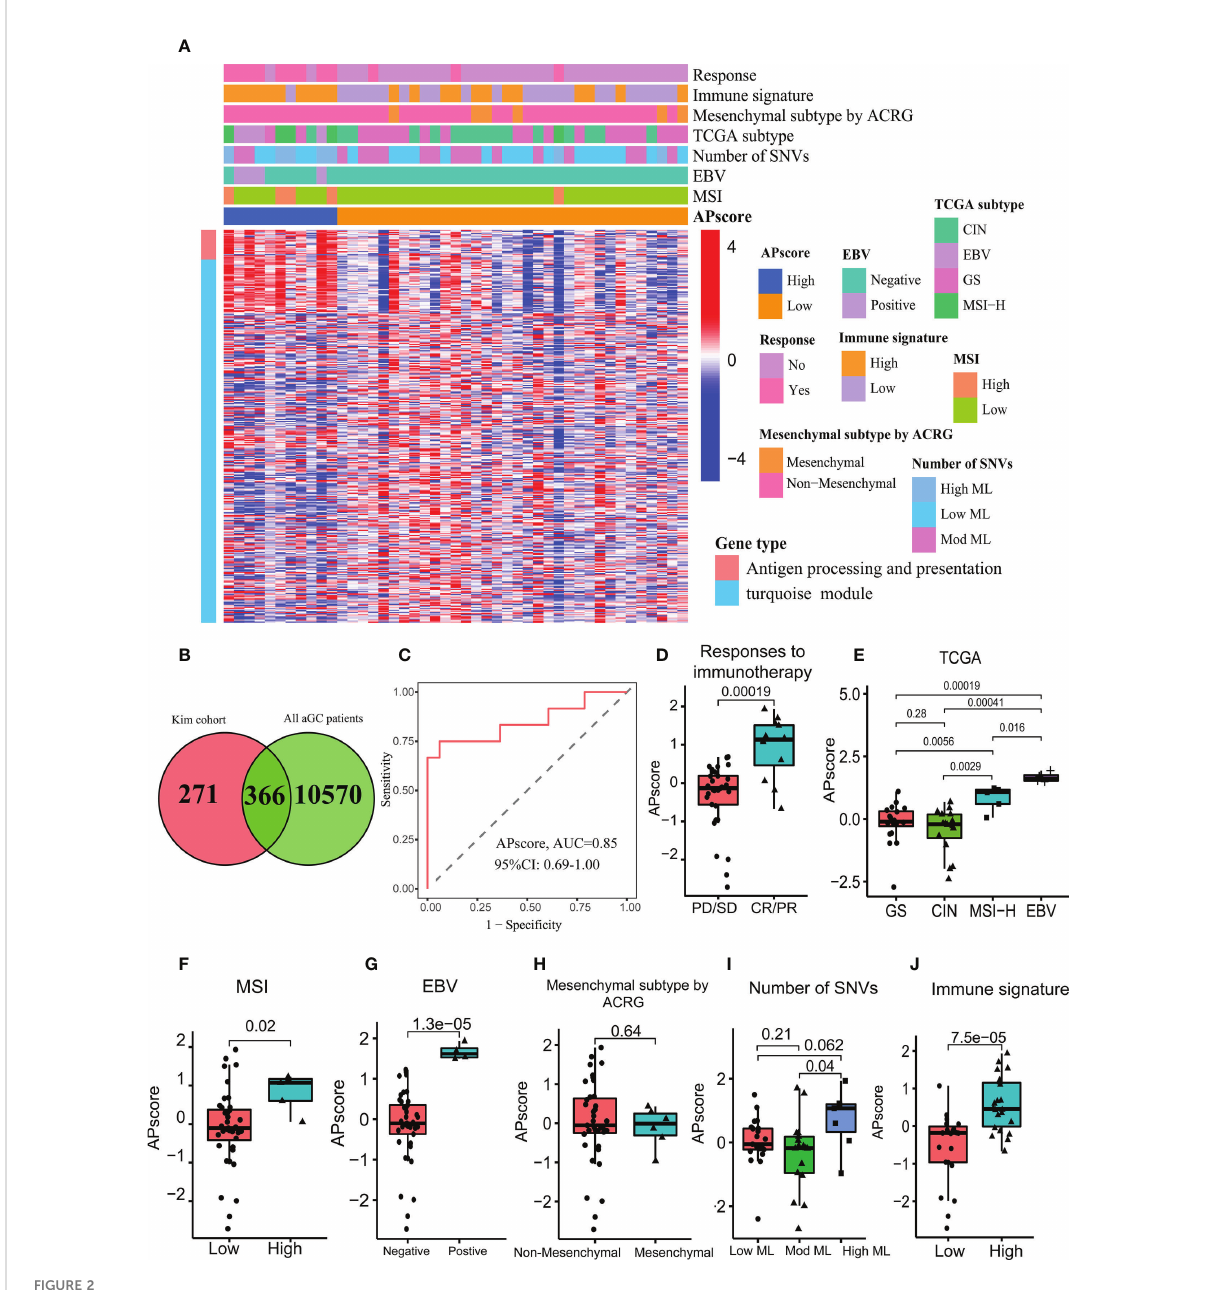
FIGURE 2 The characteristics of the APscore as an indicator of immunotherapy response in aGC patients. (A) The relationship of the APscore with other subtypes of GC. (B) Venn showing 366 genes associated with the APscore. (C) Receiver operating characteristics (ROC) for the APscore in predicting immunotherapy response. Comparison of the APscore in different groups of responses to immunotherapy (D) , TCGA subtypes (E) , MSI subtypes (F) , EBV subtypes (G) , Mesenchymal subtypes (H) , Number of SNVs subtypes (I) and immune signature subtypes (J)